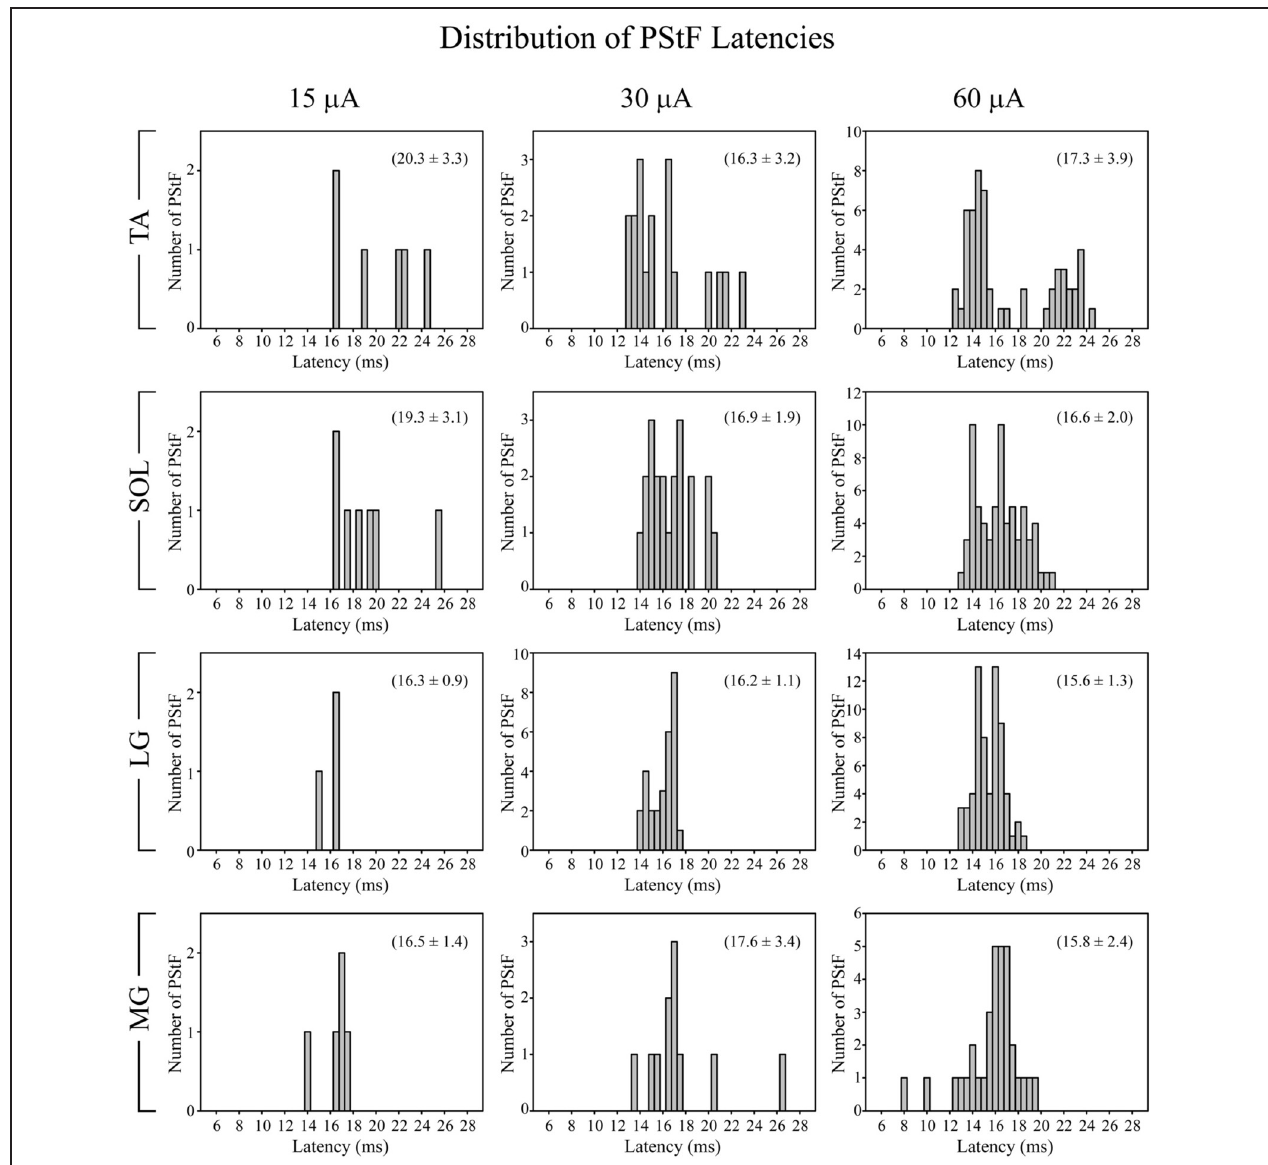
FIGURE 3 | Distribution of PStF onset latencies for ankle muscles at 15, 30, and 60 µ A stimuli. The values given in parentheses for each graph represent the mean ± SD of the onset latency of the PStF. Muscle abbreviations are the same as in Figure 1